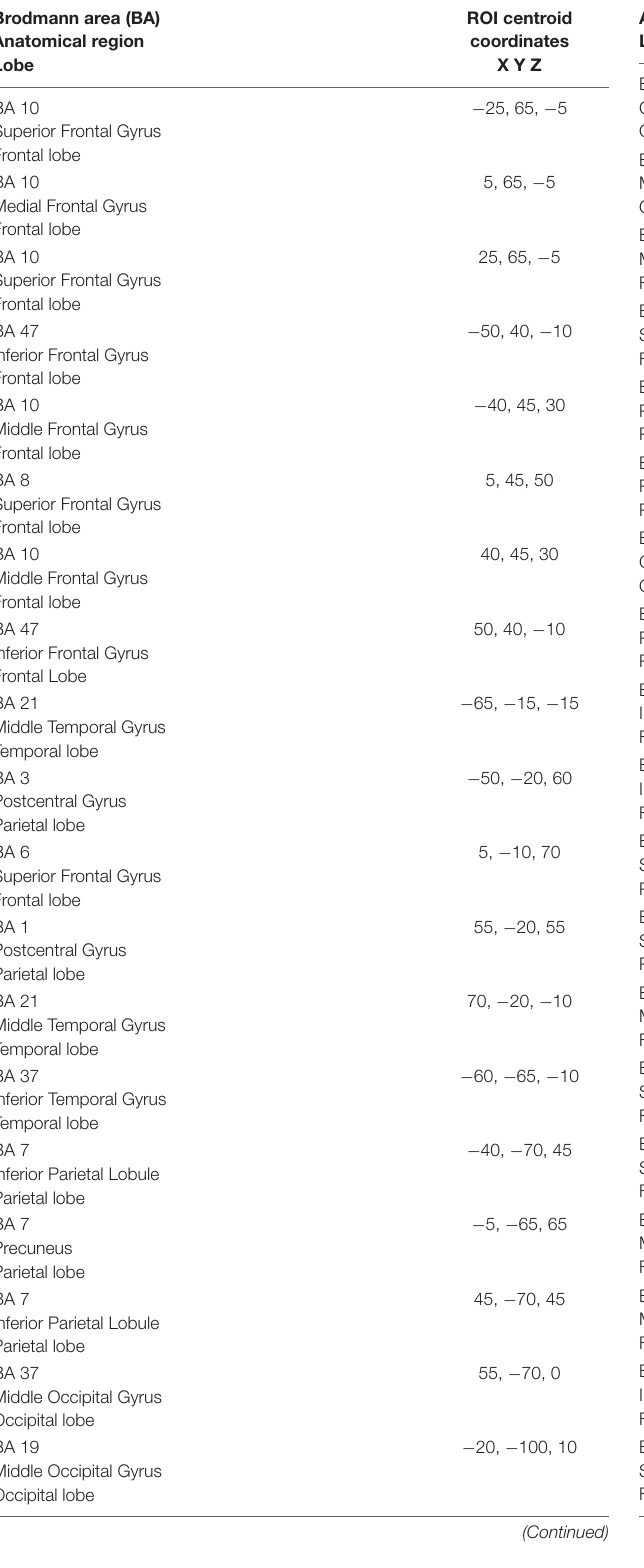
ROI centroid coordinates X Y